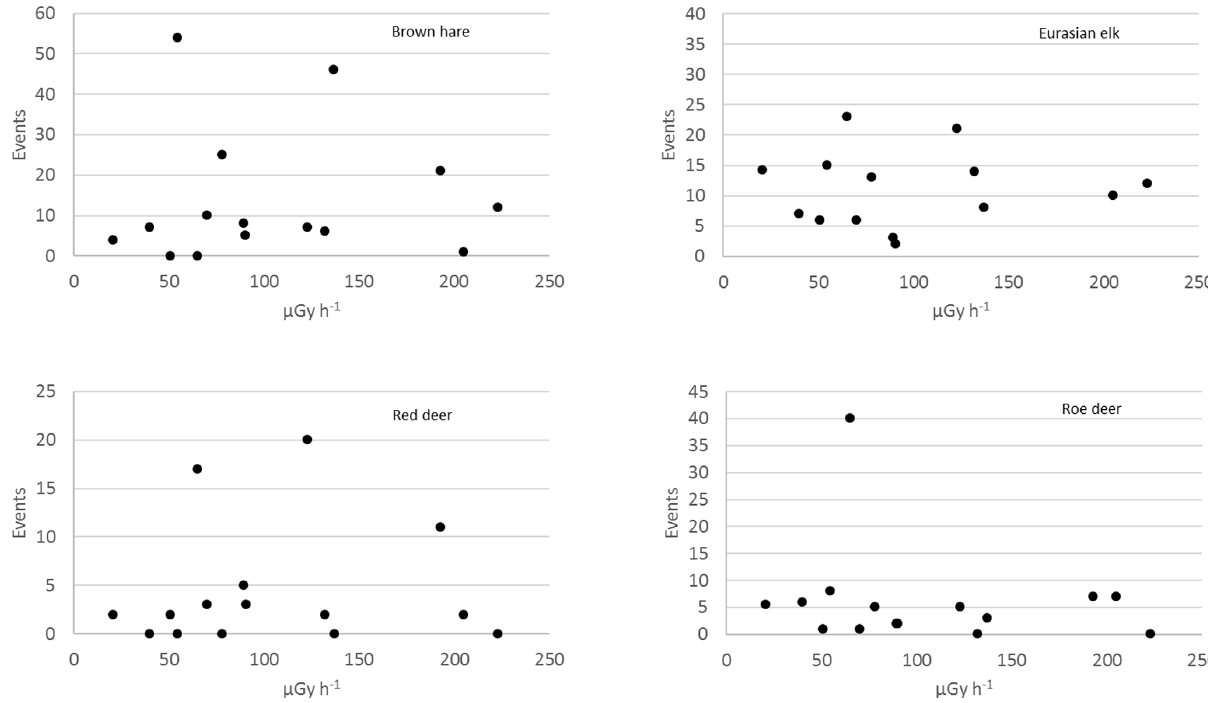
Figure 3. Relationship between number of triggering events and estimated absorbed weighted dose rates (using that calculated for the red fox geometry as an example); data presented are from setup